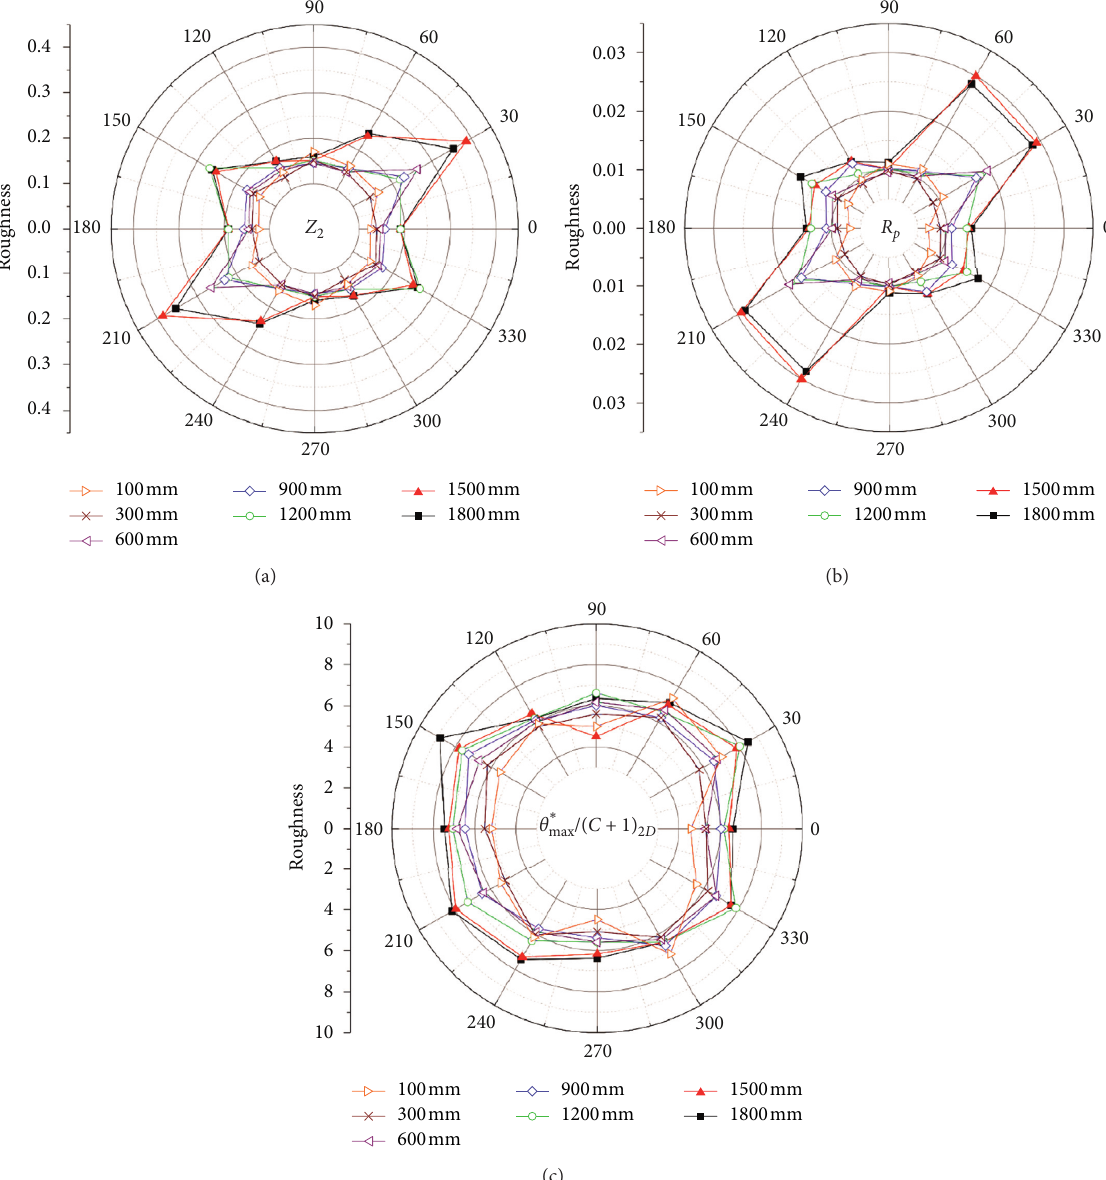
Figure 12: Polar plots of roughness parameters Z